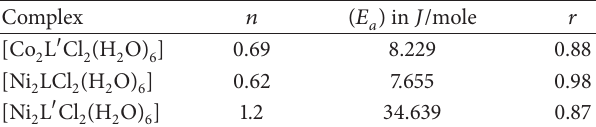
Table 5: Kinetic parameters of the